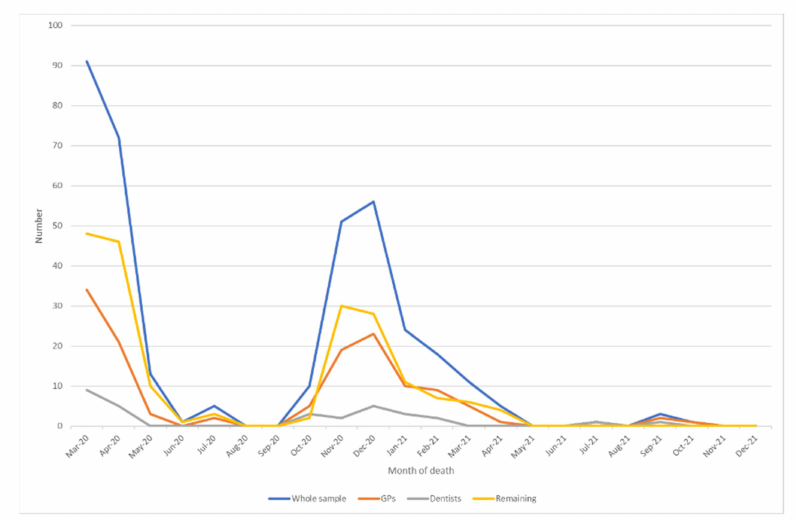
Figure 1. Time distribution of the cases (deaths) of the whole sample, GPs, dentists and remain- ing doctors.